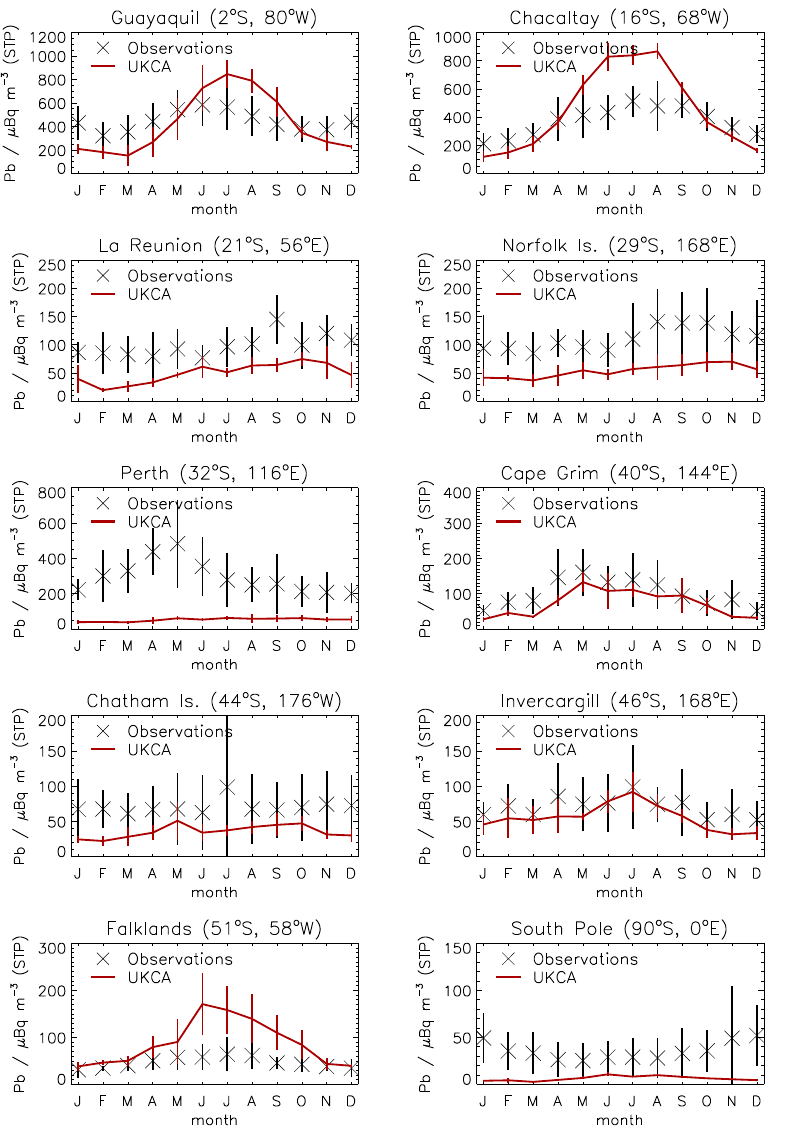
Fig. 6. Comparison of modelled surface lead concentrations in units of µBqm − 3 (STP) with surface observations for a number of sites in the Southern Hemisphere. Observations are shown as black crosses and the UKCA model is shown in red. Measurements are taken from the Surface Air Sampling Program database of the Environmental Measurements Laboratory (EML) (http://esd.lbl.gov/research/facilities/eml/).